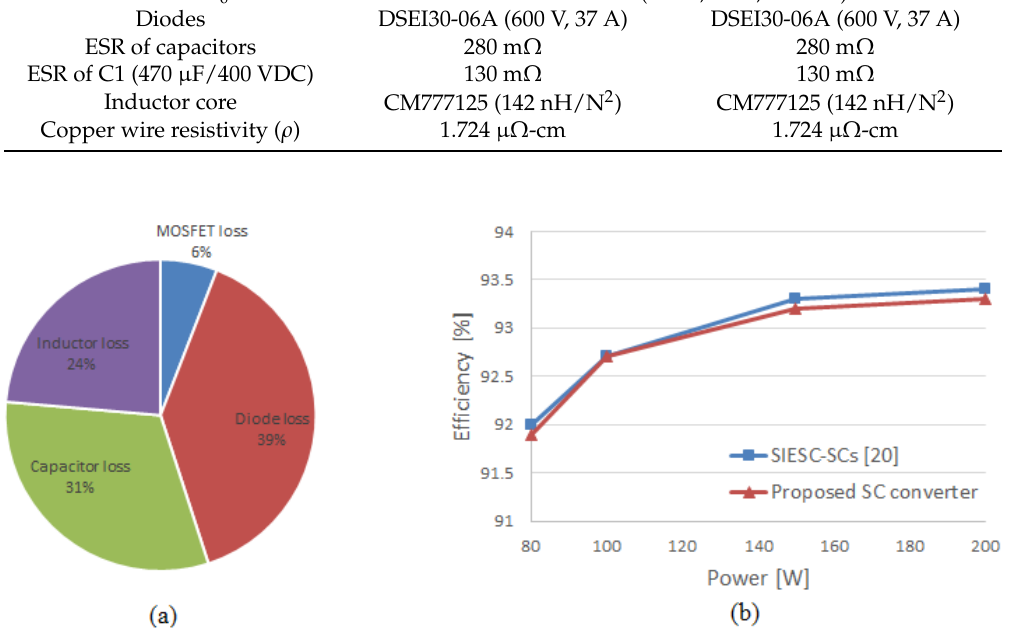
Figure 7. Power loss calculation. ( a ) Power loss of the proposed SC converter, and ( b ) comparison of the calculated efficiency.